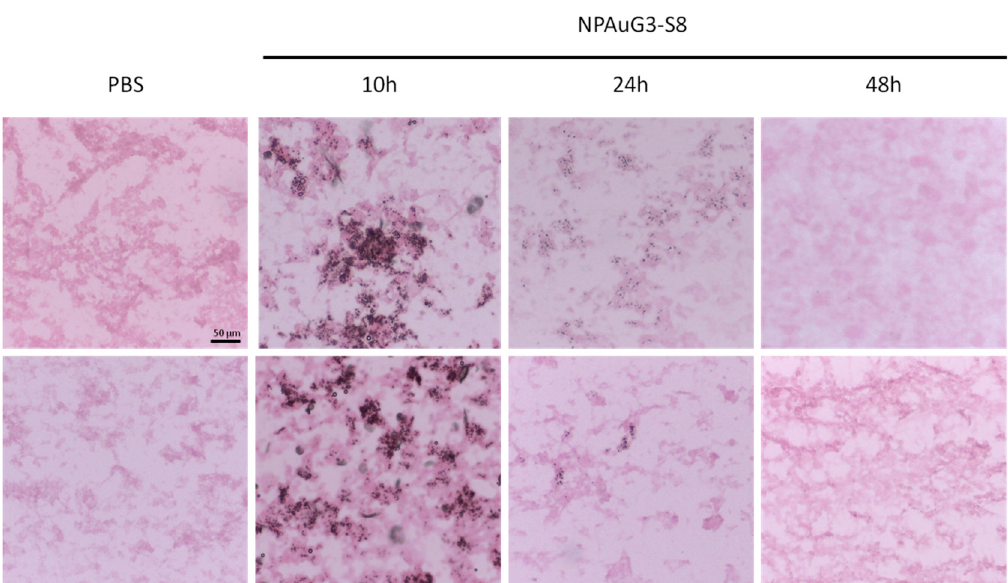
Figure 9. NPAuG3-S8 accumulation in brain tissue. Representative images for the presence of NPAuG3-S8 in brain tissue. The images show that NPAuG3-S8 at 10 h and 24 h cross the (blood-brain barrier) BBB and at 48 h it does not cross the BBB stained with silver enhancement and counterstained with eosin. PBS = Negative control of silver enhancement stain. All images were obtained at the same size as the scale bar shown.